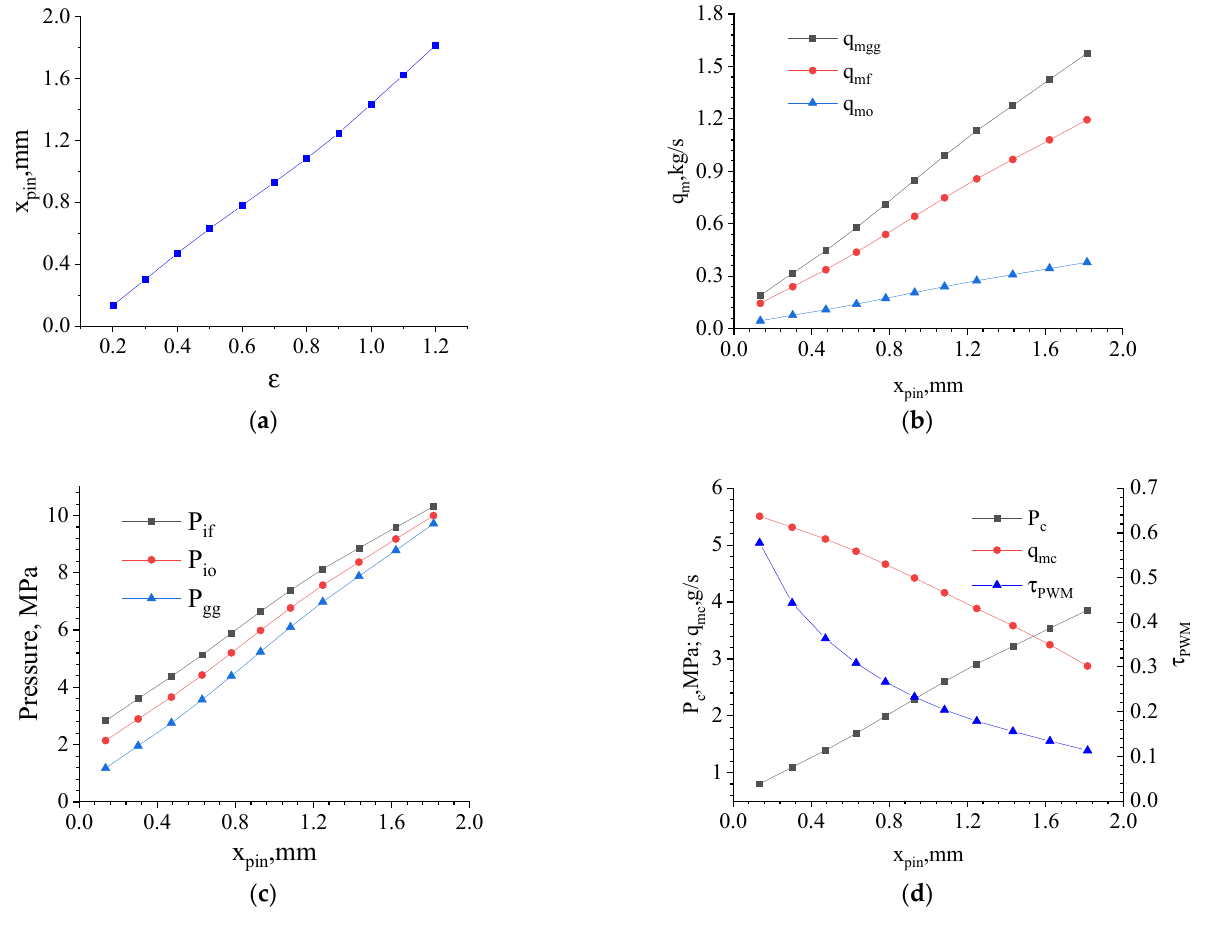
Figure 4. Steady-state operating characteristics of the IFRGG. ( a ) ε -x pin steady-state relationship. ( b ) x pin -q m steady-state relationship. ( c ) x pin -P if /P io /P gg steady-state relationship. ( d ) x pin -P c / τ PWM steady-state relationship.